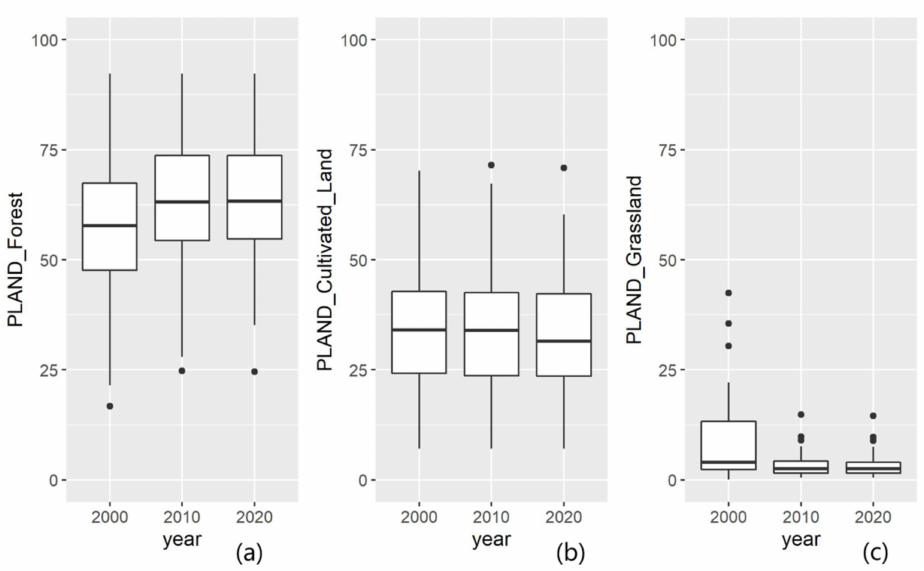
Figure 4. Boxplots of the results of the percentage of landscape (PLAND) of the 73 village buffer zones in 2000, 2010, and 2020. ( a ) PLAND of forest; ( b ) PLAND of cultivated land; ( c ) PLAND of